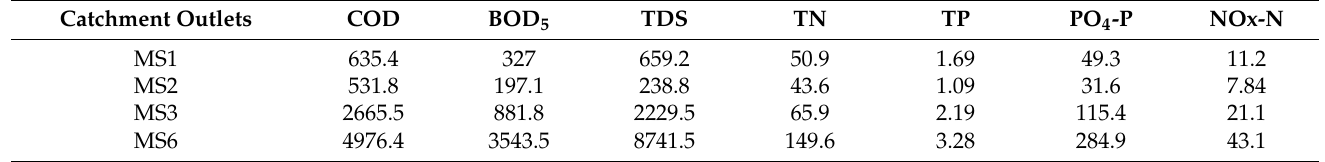
Table 10. Pollutant flux at catchment outlets of LHW by using PLOAD, t/y.